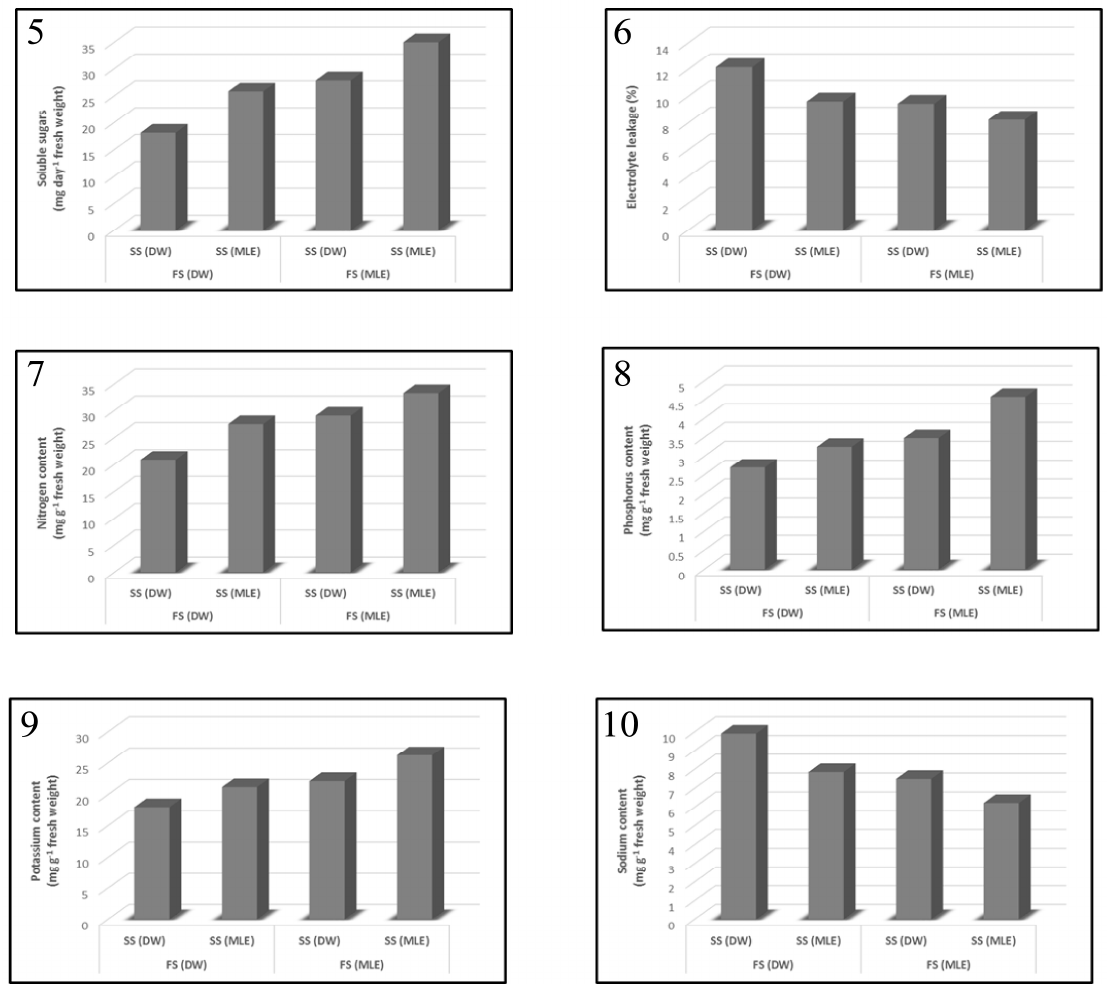
Figure 1. Effect of foliar spray (FS) and/or seed soaking (SS) with MLE or distilled water (DW) on ( 1 ) green pod yield, ( 2 ) chlorophyll a, ( 3 ) chlorophyll b, ( 4 ) carotenoids, ( 5 ) soluble sugars, ( 6 ) electrolyte leakage, ( 7 ) nitrogen content, ( 8 ) phosphorus content, ( 9 ) potassium content and ( 10 ) sodium content of Pea ( Pisum sativum L.) plants growing under salinity stress condition [66].